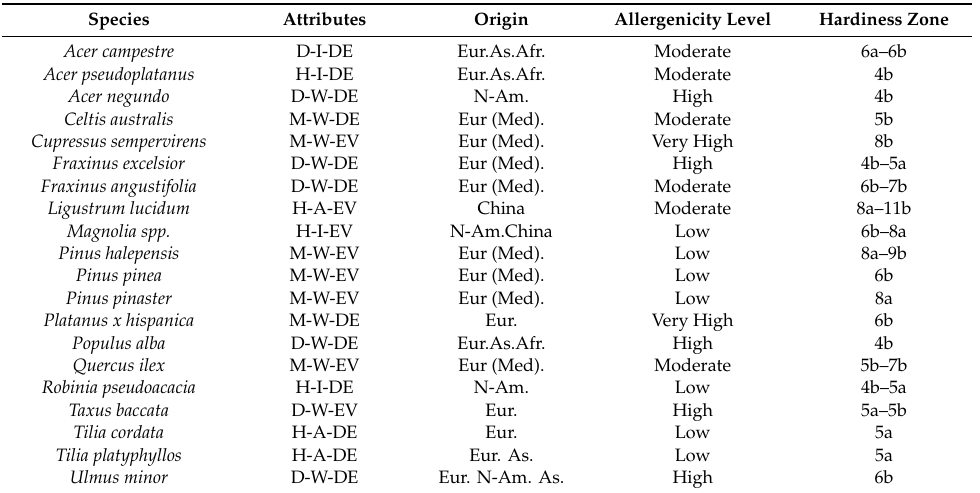
Table 3. Attributes, origin, allergenicity and hardiness zones of the 20 most-frequent species in Mediterranean parks.